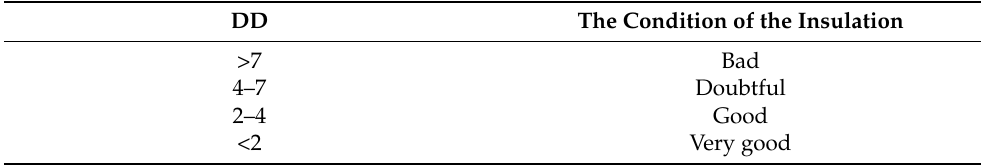
Table 6. The criterion for the evaluation of the dielectric discharge measurement.